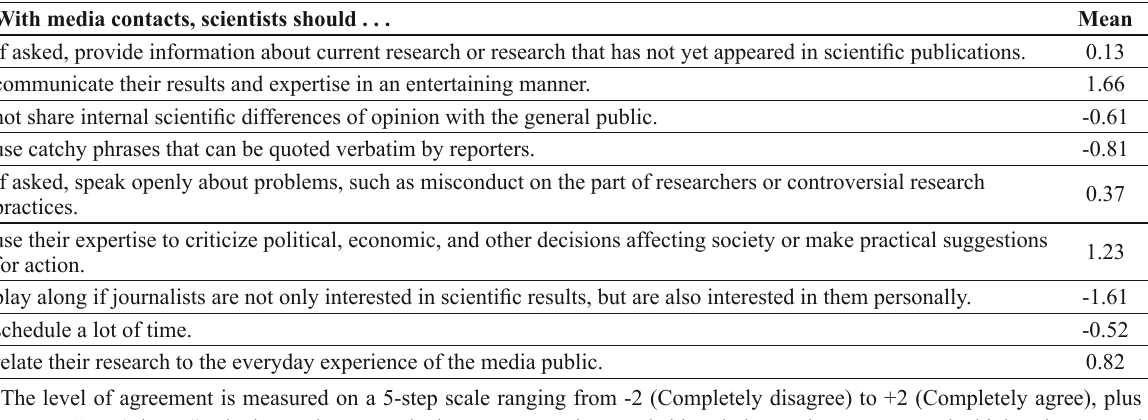
Level of agreement of how scientists should act with media contacts*. With media contacts, scientists should . .